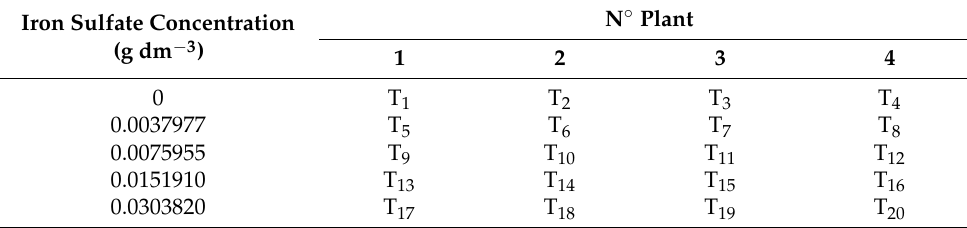
Table 7. Treatments by iron